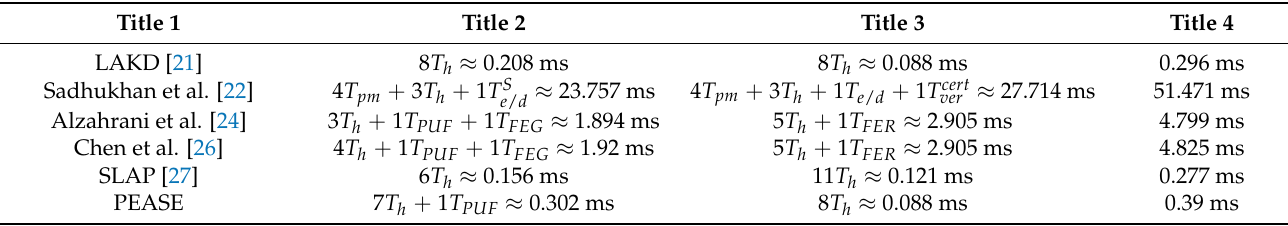
Table 7. Comparison of computational